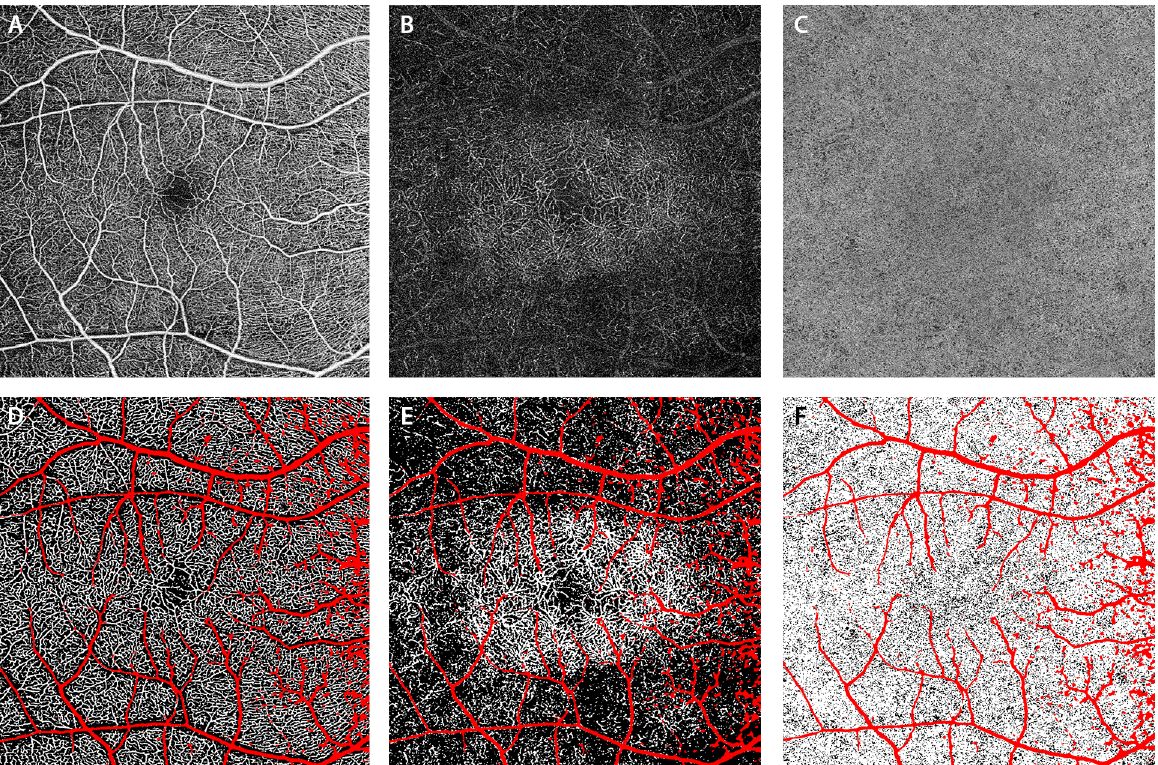
Figure 2. Optical coherence tomography angiography (OCTA) of a patient with retinitis pigmentosa, showing the superficial vascular complex (SVC, A ), the deep capillary complex (DCC, B ) and the choriocapillaris (CC, C ). All angiograms were binarized in order to quantify the vessel density (white pixels) in the SVC ( D ) and DCC ( E ) and the flow deficits (black pixels) in the CC ( F ). Larger vessels were excluded from the analysis of all plexuses (red